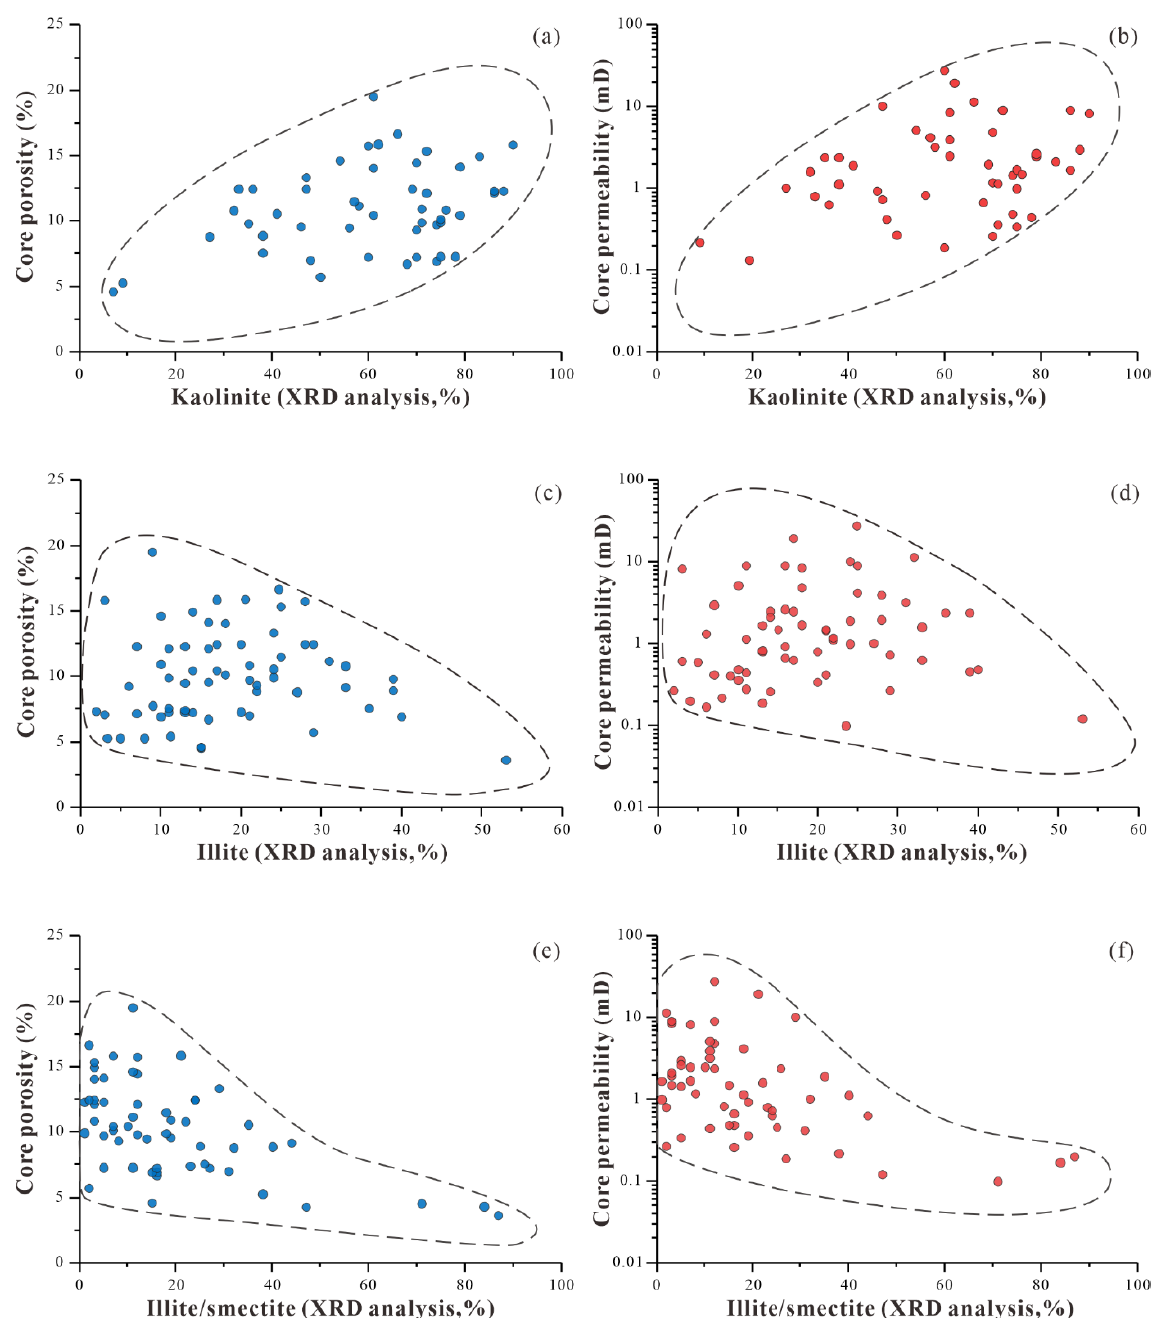
Figure 17. Relationship between different clay minerals and the reservoir physical properties: ( a ) kaolinite and porosity; ( b ) kaolinite and porosity; ( c ) illite and porosity; ( d ) illite and porosity; ( e ) illite/smectite mixed layers and porosity; ( f ) illite/smectite mixed layers and porosity.